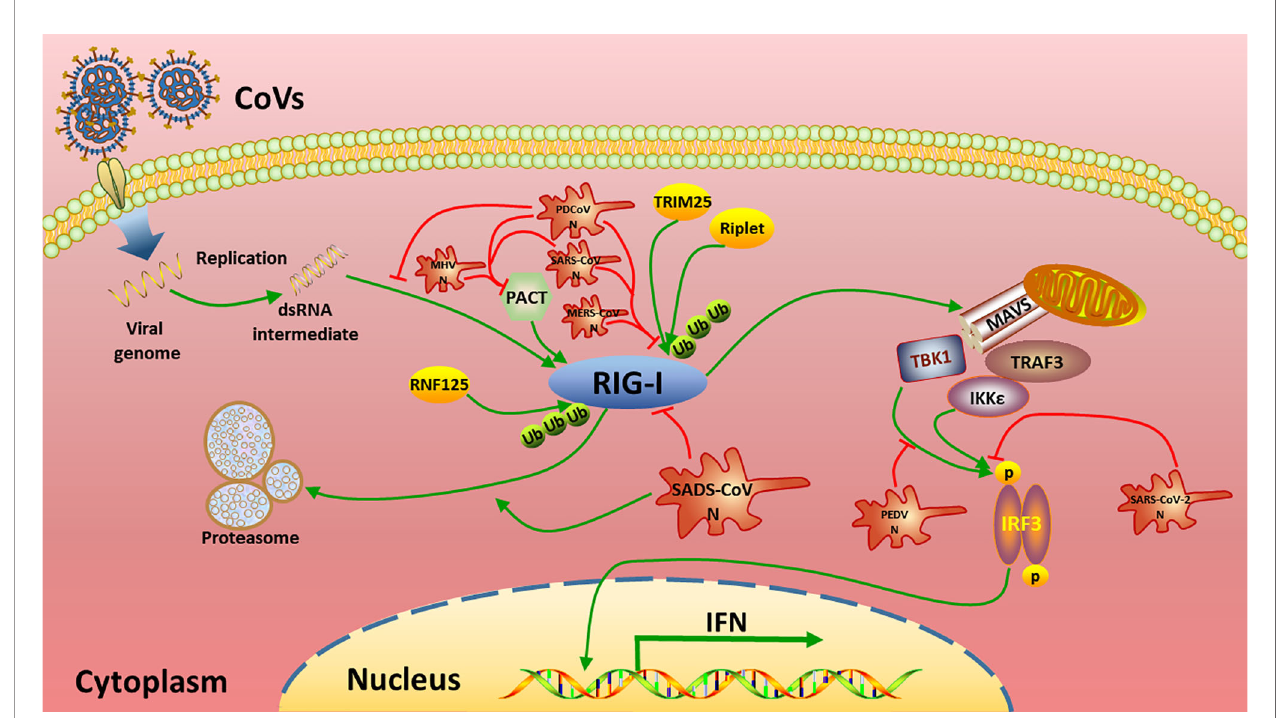
FIGURE 6 | Summary of current mechanisms underlying the inhibition of interferon (IFN) signaling by distinct CoV N proteins. The N proteins of SADS-CoV, MHV, SARS-CoV, MERS-CoV, PDCoV target the very beginning step of RLR signaling pathway (RIG-I) to inhibit IFN production, while PEDV N and SARS-CoV-2 N target TBK1 and/or downstream of TBK1 to circumvent IFN